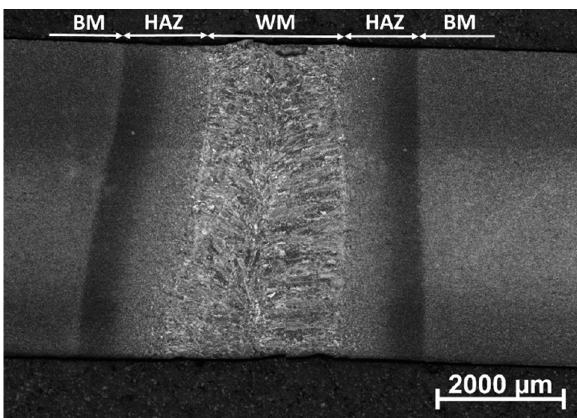
Figure 2. Macrostructure of the weld.